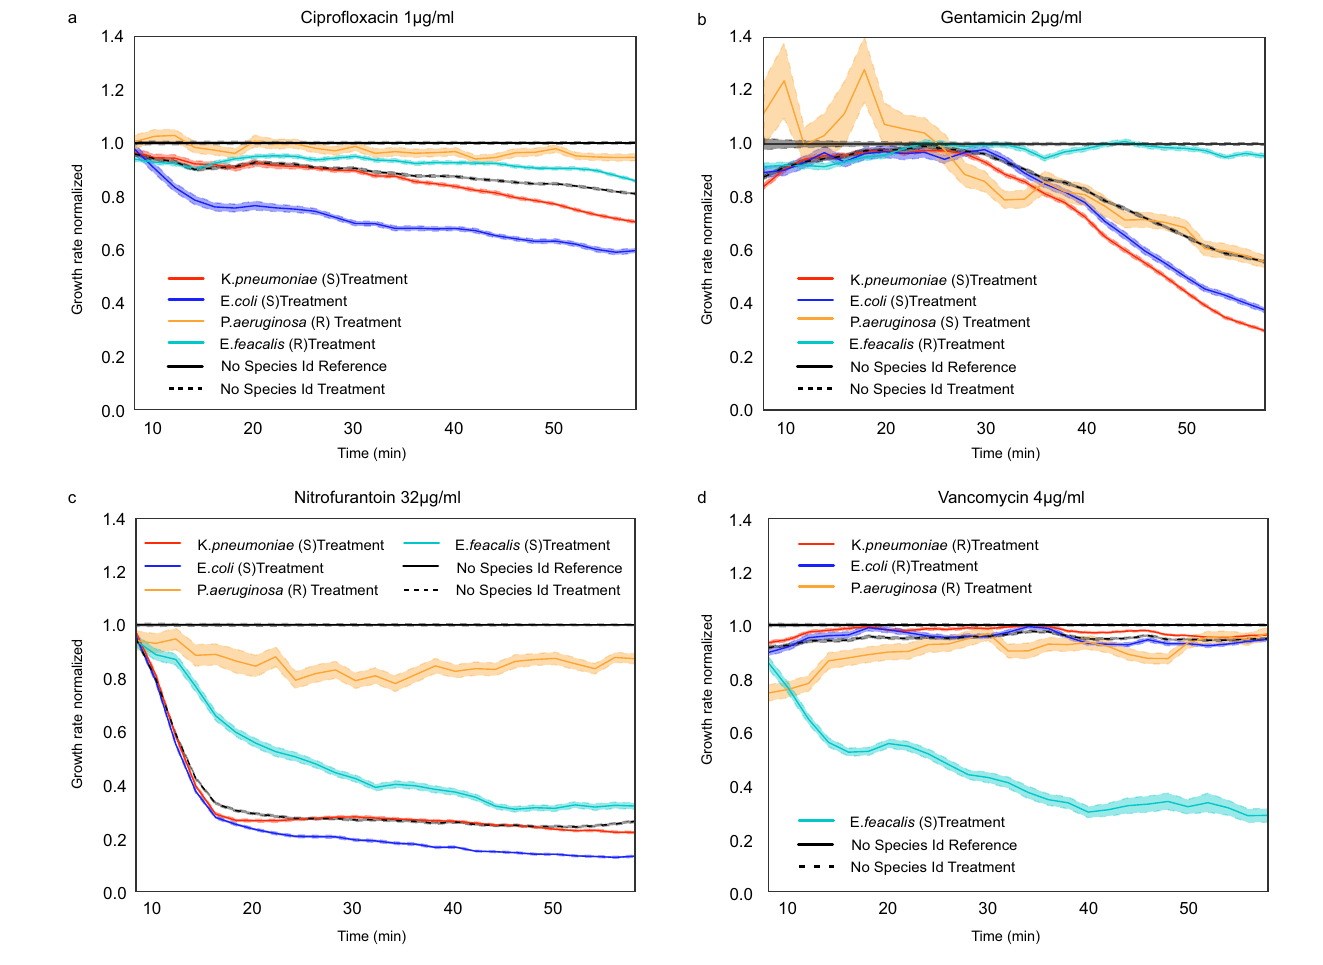
the Susceptible and Resistance, respectively. The experiment is performed once per antibiotic, although several non-reported experiments were performed for